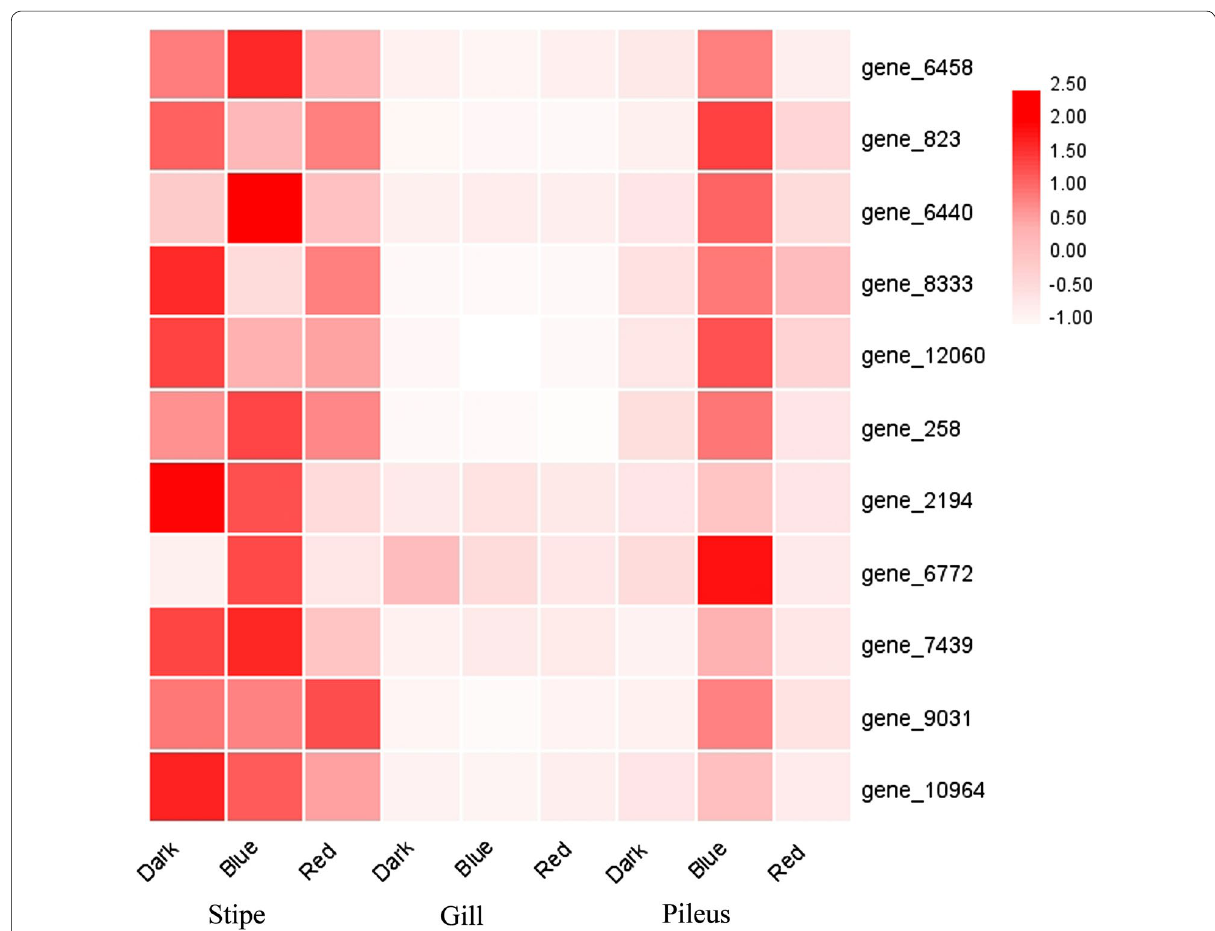
Fig. 5 Heatmap showing expression of significantly upregulated serine/threonine protein kinase genes in the pileus following blue-light treatment. When compared with dark treatment, all the 11 serine/threonine protein kinase genes were significantly upregulated in the pileus by blue-light treatment (fold change > 2, adjusted P ≤